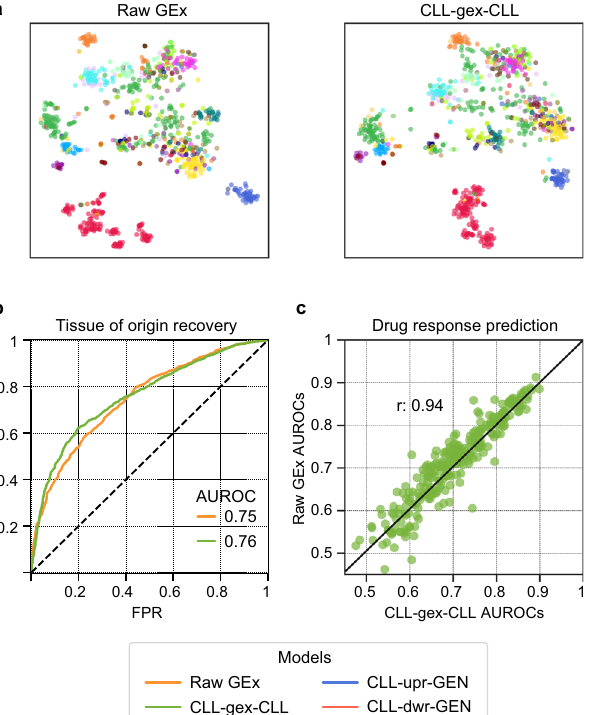
(raw) GEx (17.7K Genes) and the corresponding Bioteque metapath embedding CLL-dwr+upr-GEN-dwr+upr-CLL (hereafter CLL-gex-CLL), aimed at capturing gene expression similarities between cell lines.